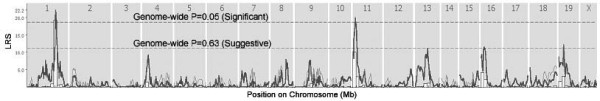
Genome scan likelihood ratio statistic plot. Depicted is a whole genome scan for QTLs affecting mouse forebrain weight. X axis depicts 19 autosomes and X chromosome. The Y axis is the likelihood ratio statistic from a single QTL model. Two QTLs, on chromosomes 1 and 11, are significant at a multiple test corrected permutation threshold as shown.